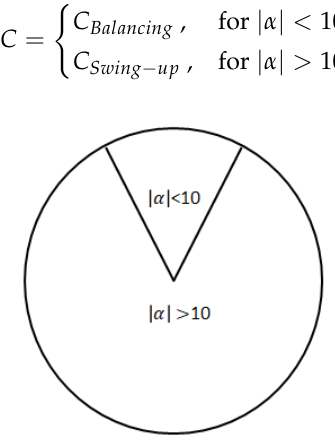
Figure 3. Switching controller